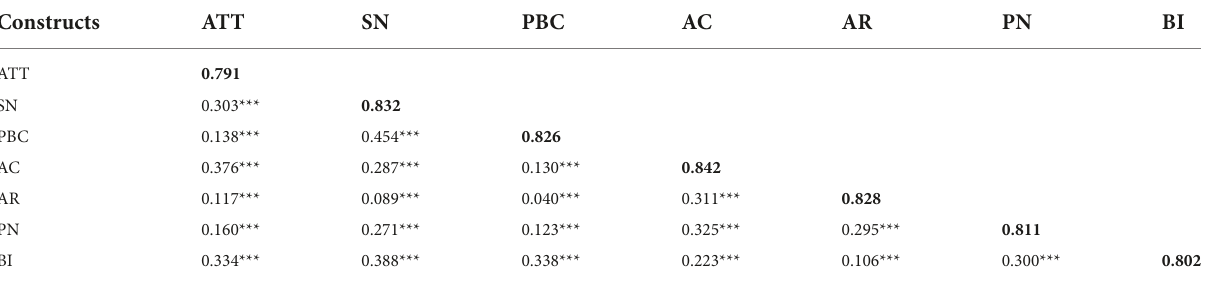
TABLE 2 Test of discriminant validity of the study constructs.